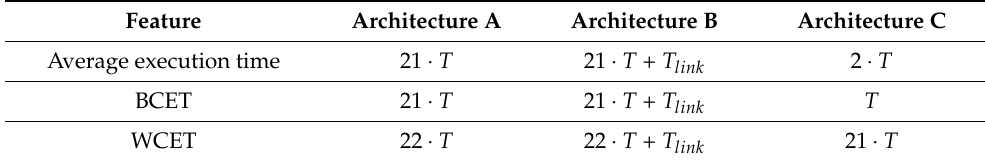
Table 5. Approximation of simulation results.